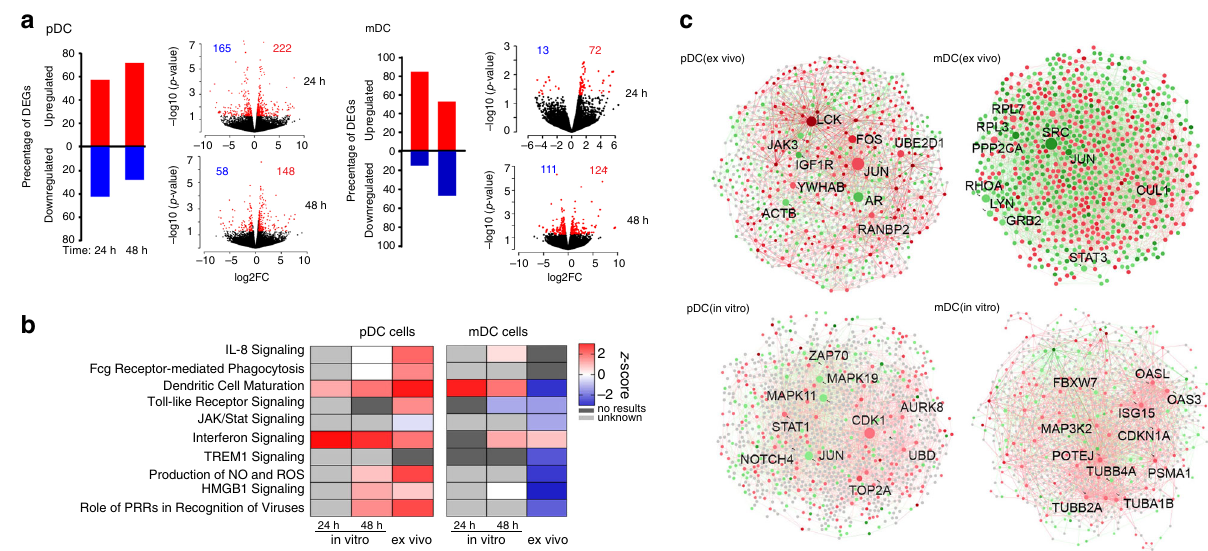
Fig. 4 Effective restriction of ZIKV infection in pDCs. a Bar diagrams indicating the proportion of upregulated (red) and downregulated (blue) transcripts in mDCs and pDCs at 24 h and 48 h after in vitro exposure to ZIKV. Volcano plots demonstrate the fold change in gene expression intensity of DEGs, plotted against the corresponding p -value. b Canonical pathway analysis (determined by IPA) of DEGs in pDCs and mDCs at indicated time points after in vitro exposure to ZIKV (in vitro), or in cells derived from ZIKV-infected individuals (ex vivo). c Network of differentially expressed genes in pDCs and mDCs plotted using the STING interactome database. Data from ex vivo and in vitro analysis are shown. Visualization was performed using Networkanalyst 62 . Upregulated genes are indicated in red and downregulated genes in blue. Top10 genes with highest connectivity scores are considered hub genes and indicated in the fi Fig. 1d), possibly due to insuf fi cient ef fi cacy of siRNA-mediated